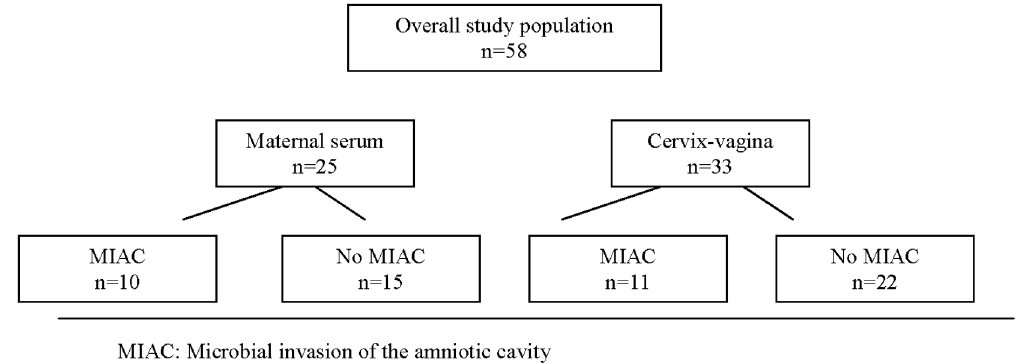
Figure 1. Clinical distribution of the study population.